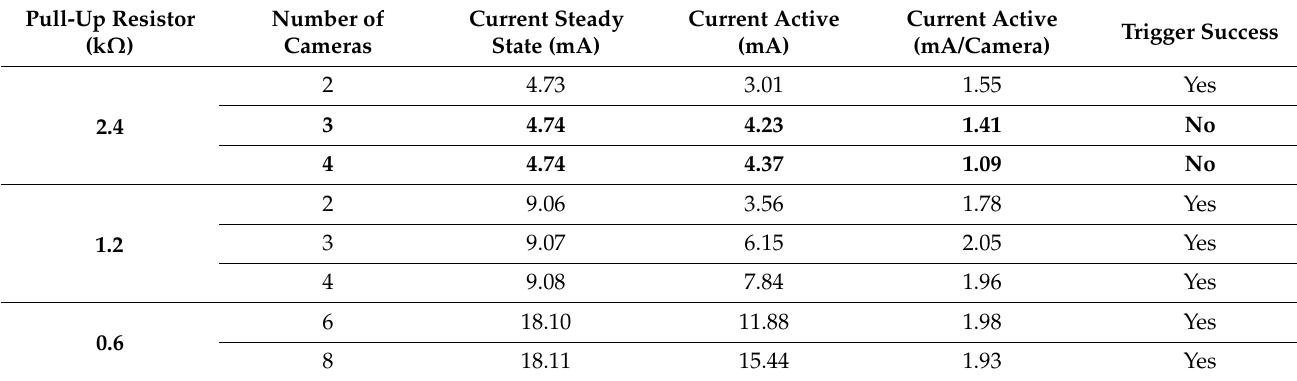
Table A2. Current draw measurements while triggering multiple cameras. Activation current per camera must be >1.5 mA to enable triggering. Bolded values caused triggering to fail.